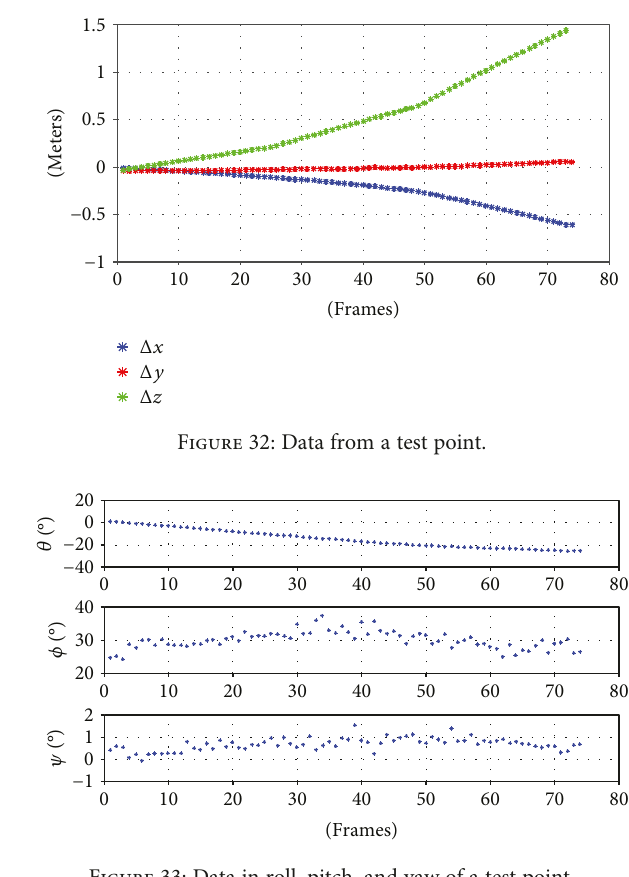
Figure 33: Data in roll, pitch, and yaw of a test